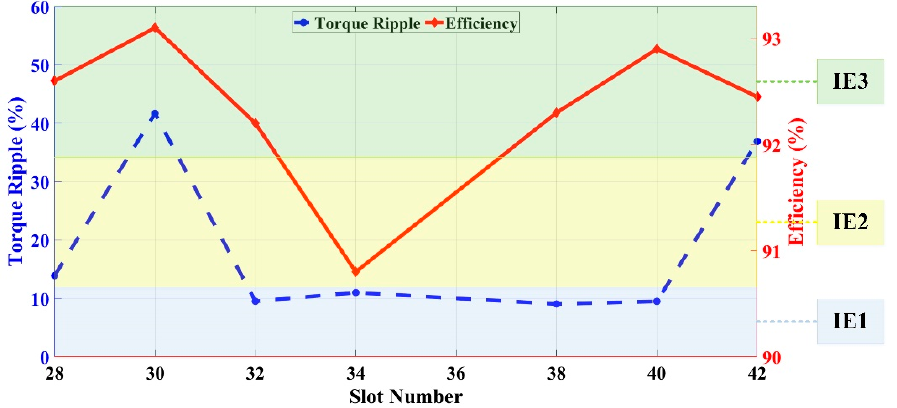
Figure 5. Efficiency and torque results of AFIM with different slot numbers. Figure 5. E ffi ciency and torque results of AFIM with di ff erent slot